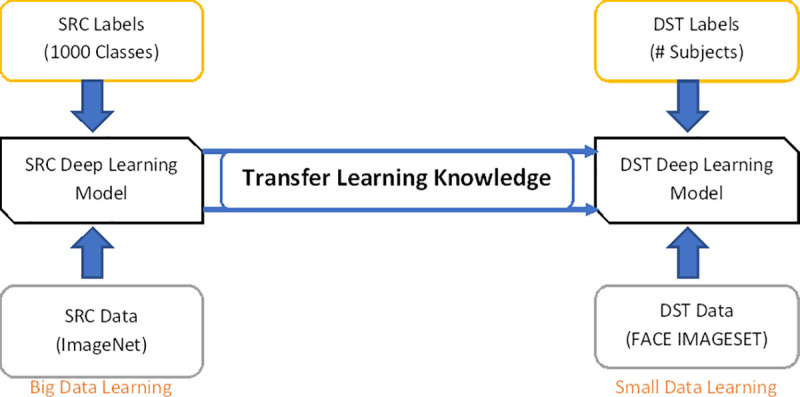
Core knowledge of transfer learning.